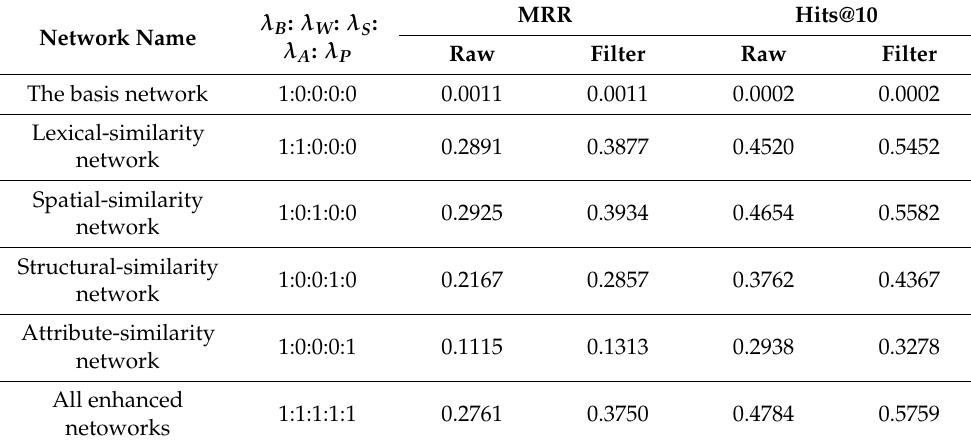
Table 6. Result of different rate of λ in